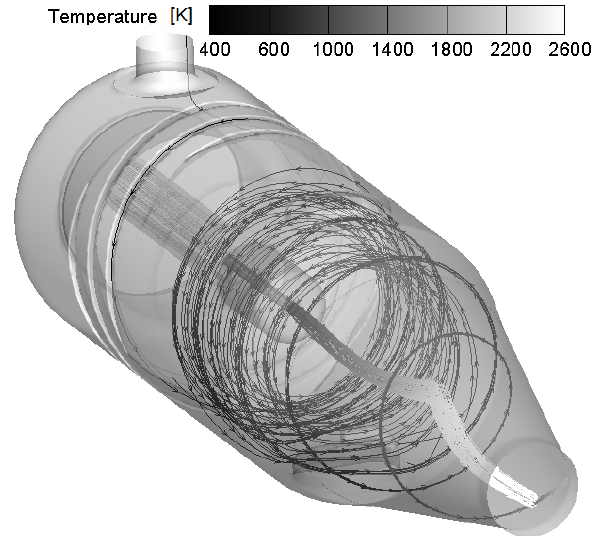
Figure 1. Streamlines distribution colored by temperature (cylindrical injector, Φ =